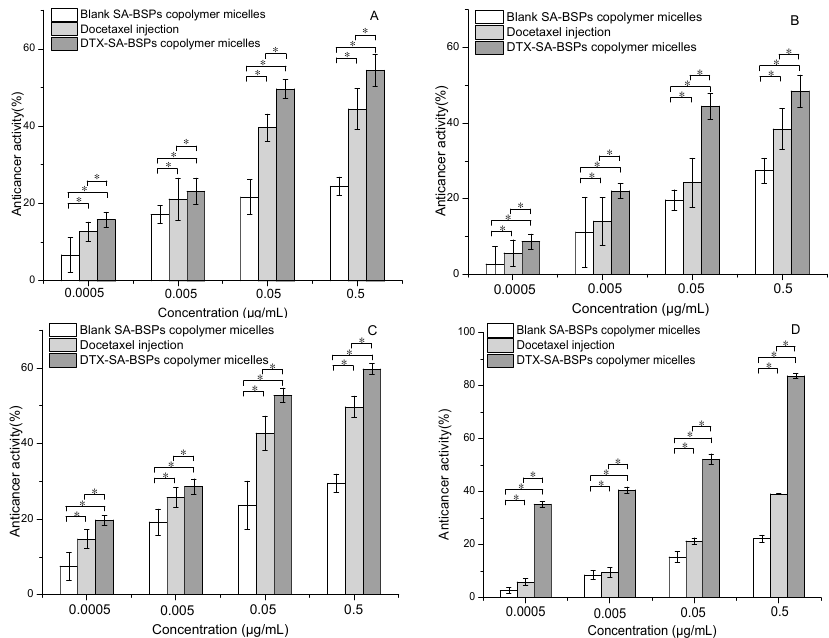
Figure 3. Anticancer activity of SA-BSPs copolymer micelles, docetaxel injection and DTX-SA-BSPs copolymer micelles on: Hela ( A ); SW 480 ( B ); MCF-7 ( C ); and HepG2 ( D ) cells after 72 h incubation (* p < 0.05).